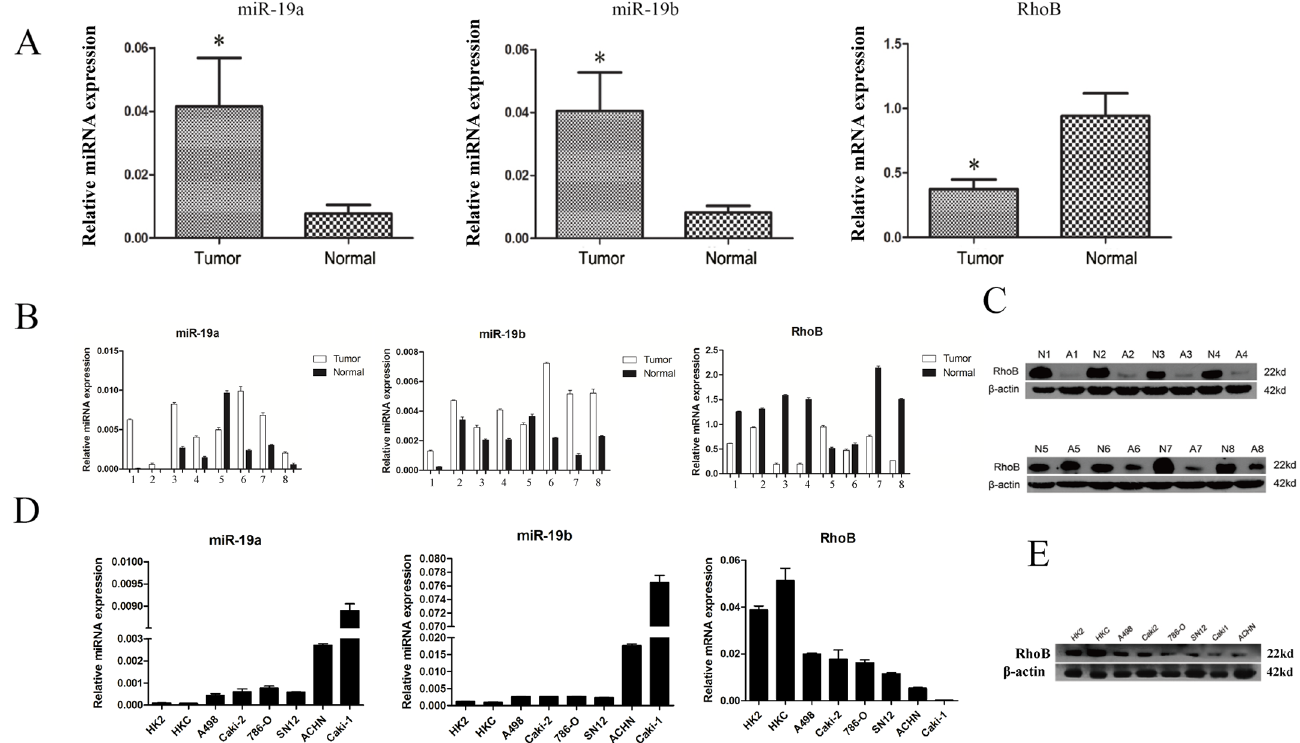
Fig 1. miR-19a/19b and RhoB expression levels are negatively correlated in patient tissues samples and cell lines. (A) QRT-PCR analysis for miR19a/b and RhoB expression in paired patient specimens (n = 70). (B) QRT-PCR analysis for miR19a/b in patient specimens (n = 8). (C) Western blot analysis for RhoB expression in the same specimens as panel B. N1-8 are normal tissues and A1-8 are paired tumor tissues. (D and E) QRT-PCR and Western blot analysis for miR19a/b and RhoB expression in normal renal cells and ccRCC cell lines. β -actin was used as loading control for western blot. The data represent the average of three independent experiments. (cid:3) Indicates statistical significance (P <